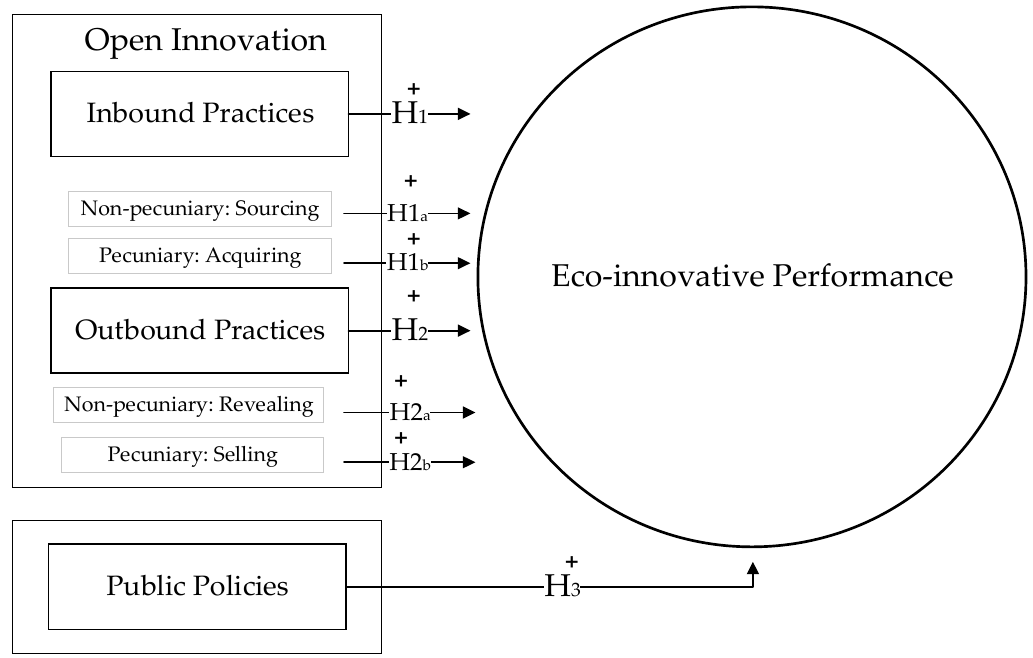
Figure 2. Inbound and Outbound Practices of Open Innovation, Public Policies and Firms’ Eco- Innovative Performance: a proposed conceptual model. Source: Own elaboration.